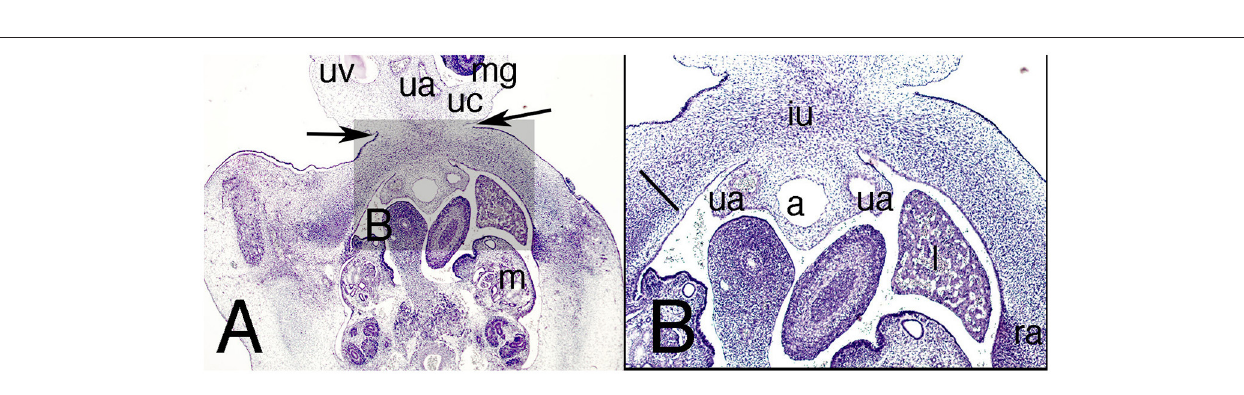
FIGURE 4 | Cross section of the abdomen of the embryo ES-18 (stage 19) at infra-umbilical level. Hematoxylin and eosin staining. (A) (2X) level just below the physiological umbilical hernia and (B) (4X) at the infra-umbilical region. a, allantois; iu, infra-umbilical region; l, liver; m, mesonephros; mg, midgut; ra, rectus abdominis; ua, umbilical artery; uc, umbilical cord; uv, umbilical vein. Arrows, neck of the physiological hernia; Bar, common mass of the internal and transversus abdominis muscles in the anterior region of the abdominal